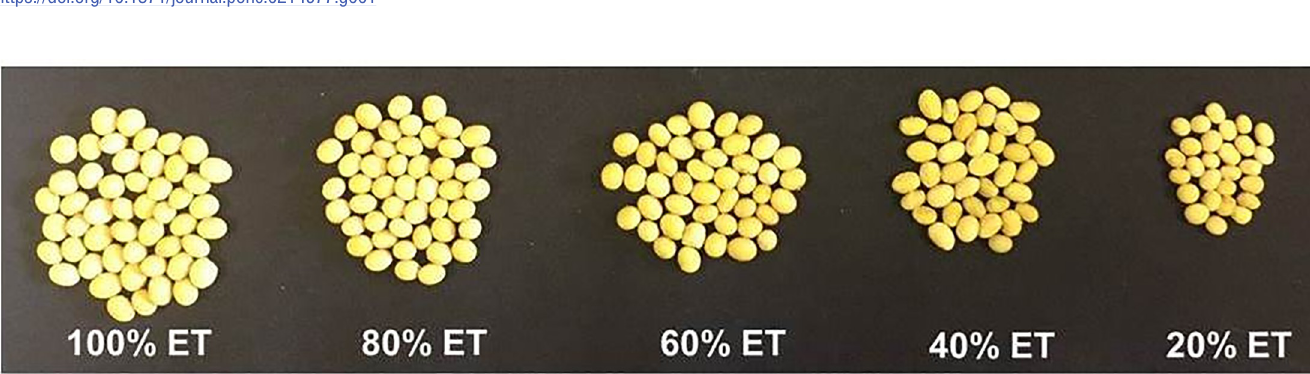
Fig 2. The effect of increasing soil moisture stress (100, 80, 60, 40, and 20% ET) on a soybean seed number, size, and shape of Asgrow AG5332 harvested 126 d after planting. Each seed lot under each treatment represents 1/10 of the total fraction of seed collected from one plant. Due to the absence of significant difference for the seed number between the cultivars, seed only from one soybean cultivar is presented.